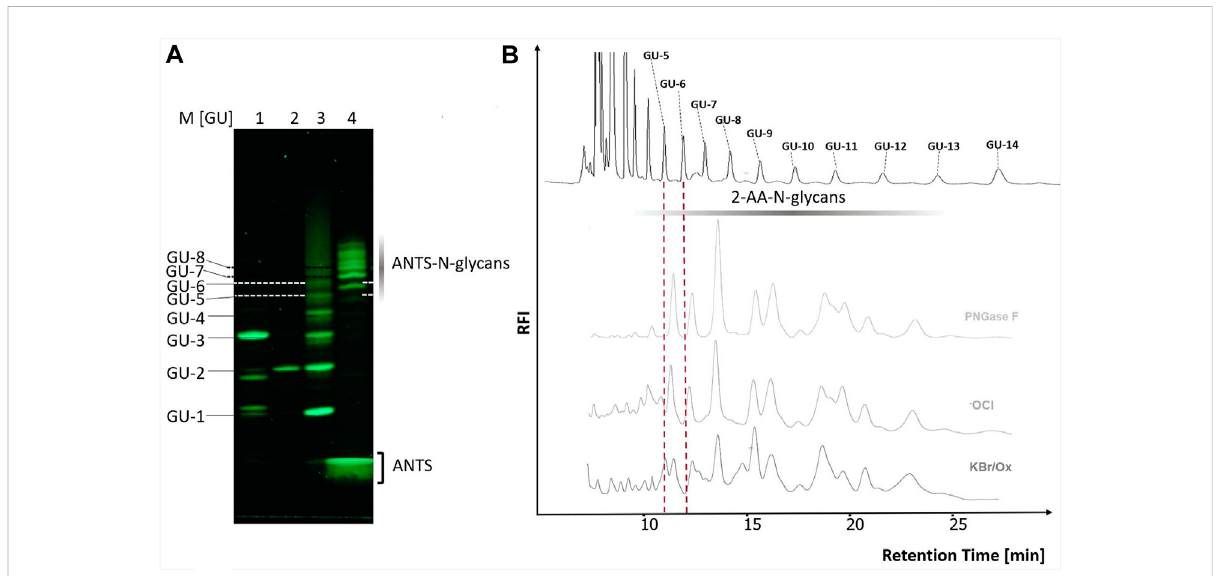
FIGURE 6 The chicken ovalbumin N-glycan pro fi les released by PNGase F and Oxone ® /Bromide are identical by FACE and HILIC-FLD analysis. (A) BHZ- FACEElectropherogramshowingtheseparationofANTS-labeledmono-,di-andtrisaccharides,dextran-hydrolysatemarkerandPNGaseFreleased N-glycans fromchickenovalbumin.Lane1:ResolvedmixofANTS-labeledmannose,lactoseandmaltotriose,Lane2:ANTS-labeledmaltoseLane3: ANTS-labeled dextran partial hydrolysate standard, Lane 4 – 6: ANTS-N-glycans released from chicken ovalbumin by PNGase F, hypochlorite and Ox/KBr, respectively. λ ex = 365 nm, recorded by 12Mpx CMOS camera. (B) HILIC-FLD peak pro fi les for 2-AA-labeled N-glycans released by either PNGase F, hypochlorite or Oxone ® /Bromide mixture with a 3.3 molar excess of bromide: Oxone ® . Column: OTU Amino 250 × 4.6 mm, isocratic solvent: 60 % ACN / 10 mM ammonium formate (pH 4.4) fl ow rate: 0.5 ml/min., column temperature: 25 ° C, fl uorescence detection: λ ex = 360 nm, λ em = 420 nm; GAIN